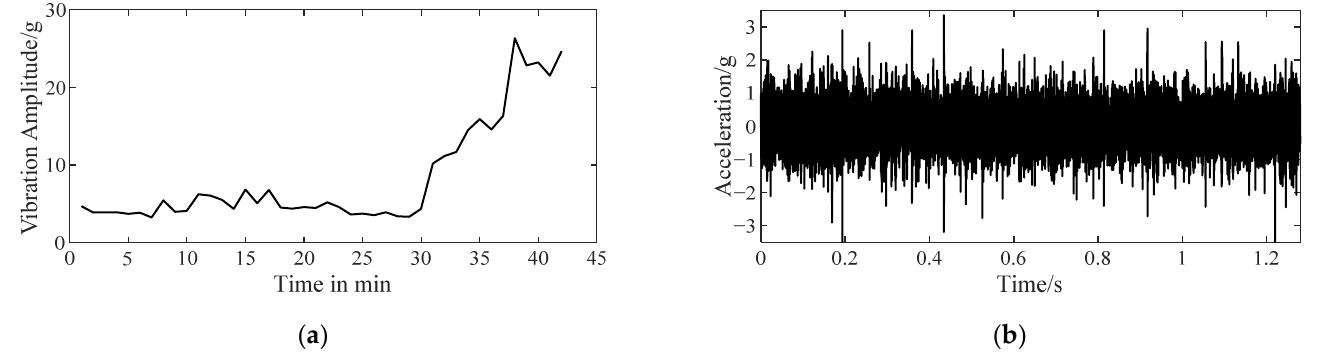
Figure 7. Vibration data of bearing 2. ( a ) The curve of maximum vibration amplitude versus time; ( b ) vibration signal measured at 9th min (initial fault).